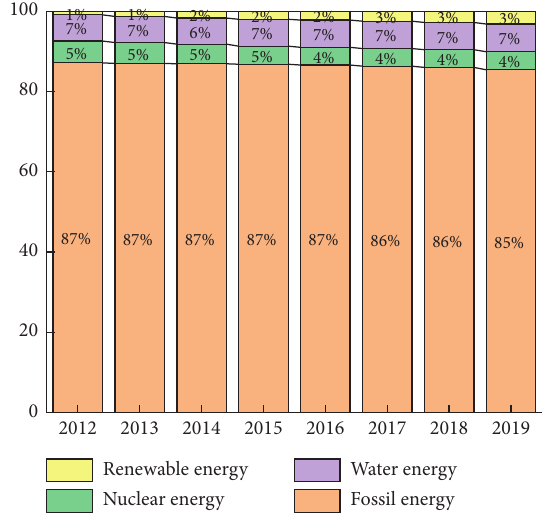
Figure 1: Share of global energy consumption structure.